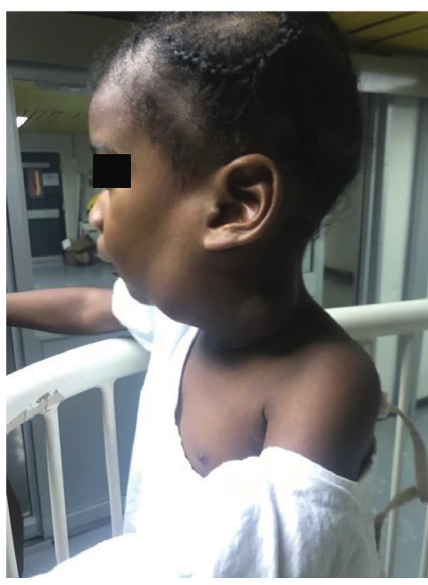
Figure 7: Cystic hygroma 3 months after treatment.